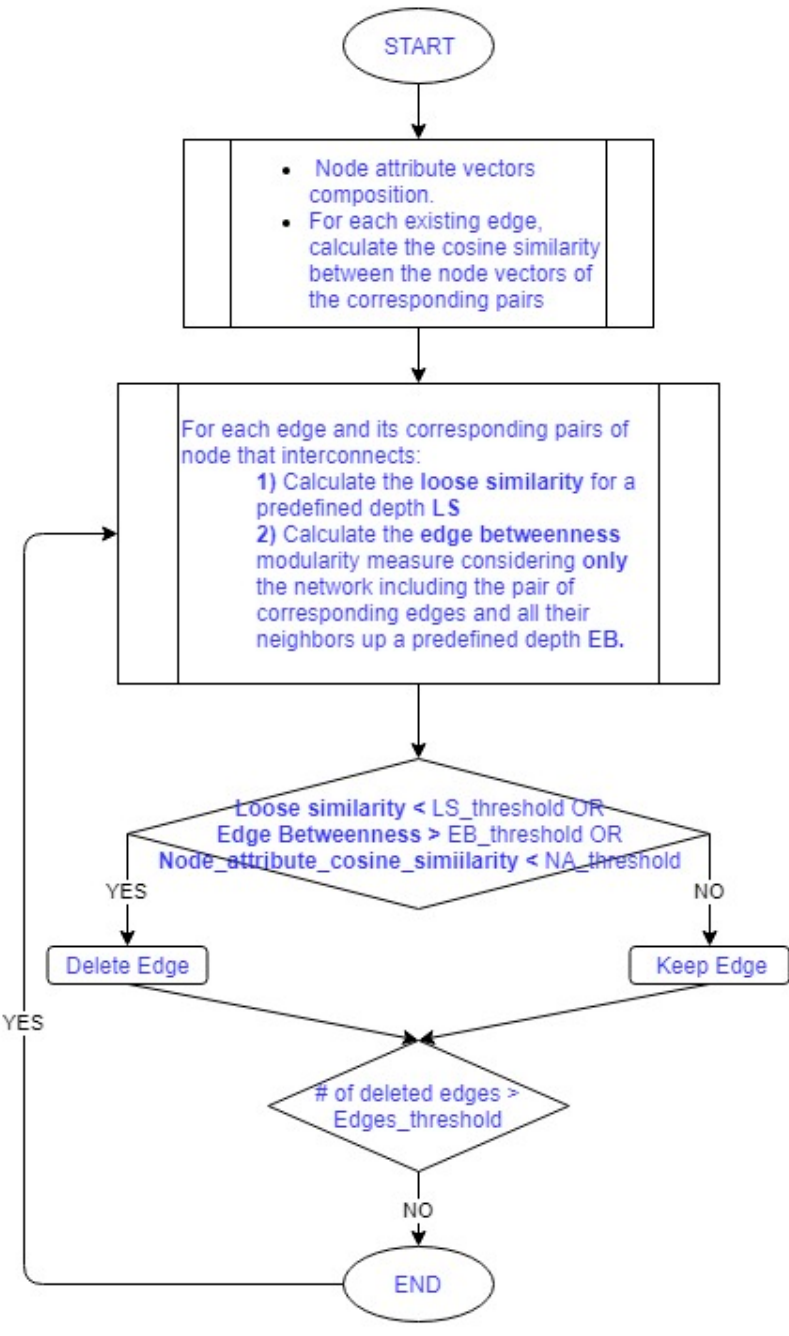
Figure 1. The proposed methodology flowchart.